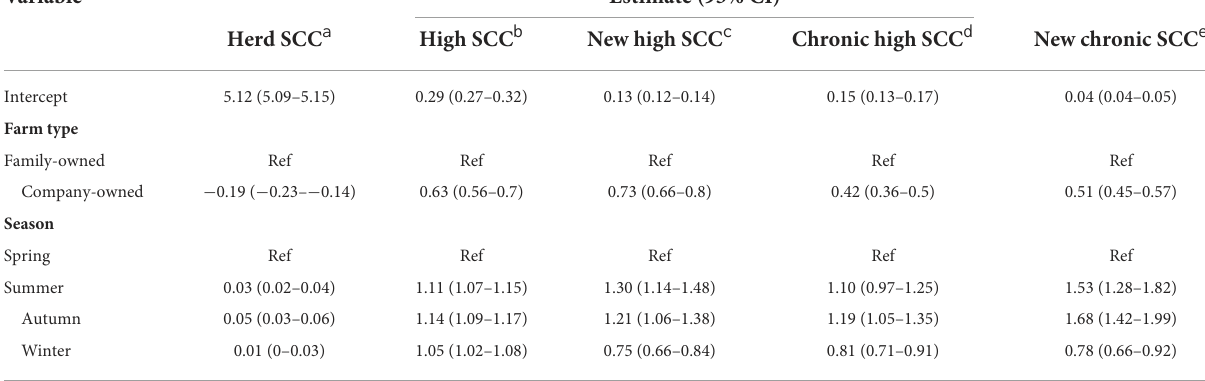
TABLE 4 Factors associated with herd-level SCC among 131 herds in 11 provinces.